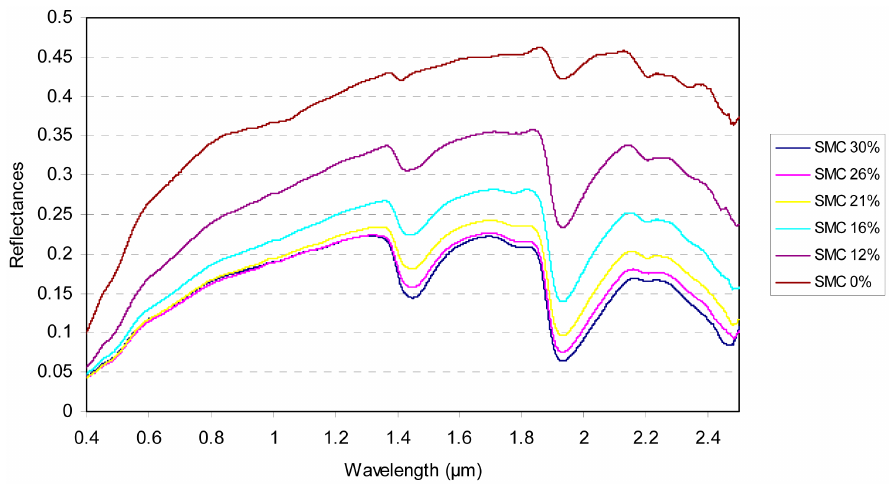
Figure 2. Measured spectra of a soil sample with different soil moisture, c.f. Fabre et al. [42]. Water content also affects the reflectance of crops, mainly in NIR and SWIR bands